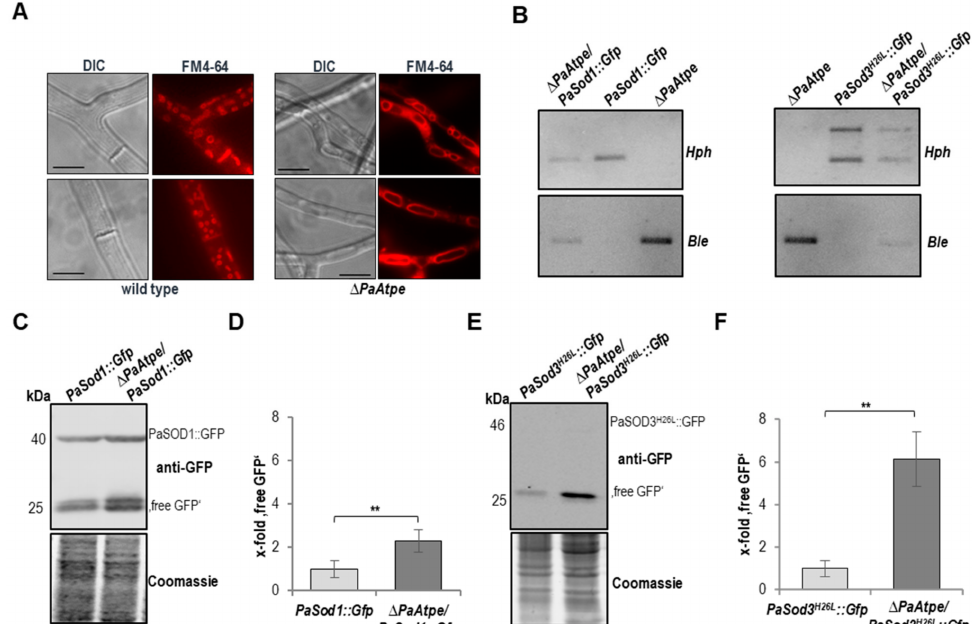
Figure 3. Loss of F 1 F o -ATP-synthase dimers induced autophagic processes ( A ) Fluorescence microscopy of 6-day-old P. anserina wild-type and ∆ PaAtpe strains after cultivation for one day before microscopic analysis on M2 medium. Staining of vacuole membrane with 2 µ g/mL FM4-64 for 5 h. Scale bars: 10 µ m. ( B ) Southern blot analyses verify the newly generated double mutants ∆ PaAtpe/PaSod1::Gfp and ∆ PaAtpe/PaSod3 H26L ::Gfp by the phleomycin ( Ble ) and the hygromycin ( Hph ) resistance genes. ( C ) Monitoring non-selective autophagy by western blot analysis of total protein extract from PaSod1::Gfp and ∆ PaAtpe/PaSod1::Gfp cultures with a GFP-antibody (each 6 biological replicates). ( D ) Quantification of “free GFP” protein level from (C) normalized to the Coomassie stained gel. Protein level in PaSod1::Gfp cultures were set to 1. ( E ) Monitoring mitophagy by western blot analysis of total protein extract from PaSod3 H26L ::Gfp and ∆ PaAtpe/PaSod3 H26L ::Gfp cultures with a GFP-antibody (each 4 biological replicates). ( F ) Quantification of “free GFP” protein level from (E) normalized to the Coomassie stained gel. Protein level in PaSod3 H26L ::Gfp cultures were set to 1. Error bars correspond to the standard deviation and p -values were determined by two-tailed Student’s t test. ** p <